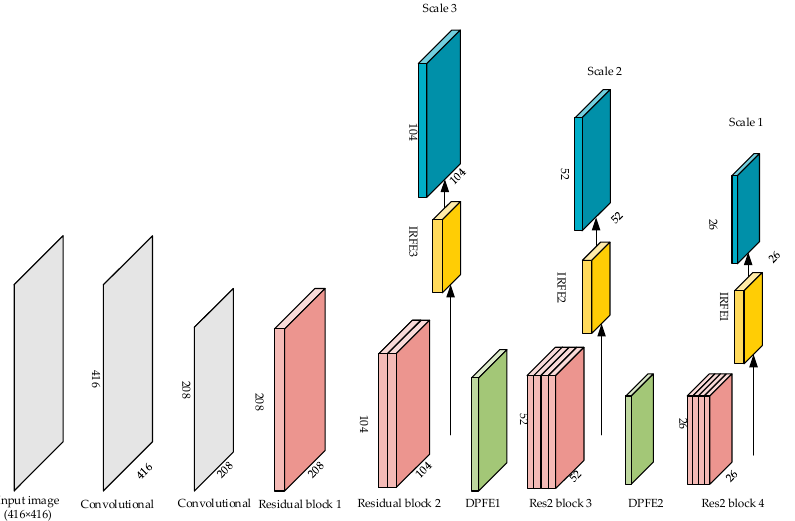
Figure 11. The structure of FE-YOLO.